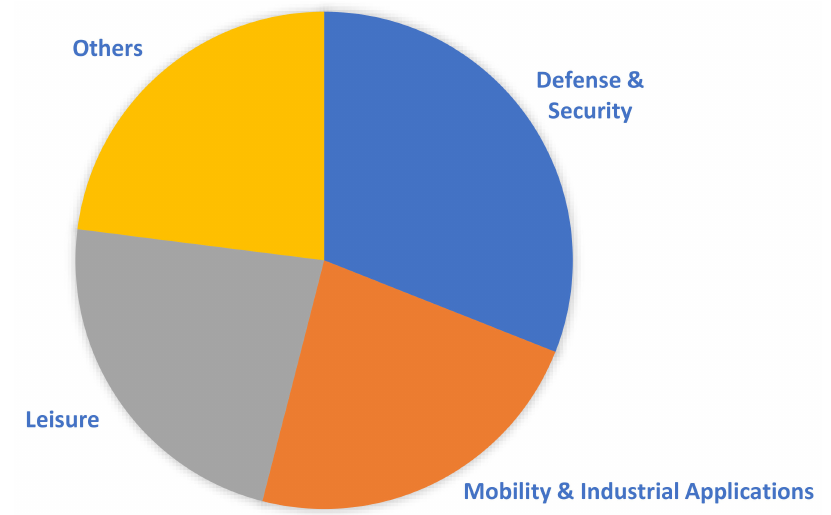
Figure 3. Main applications of